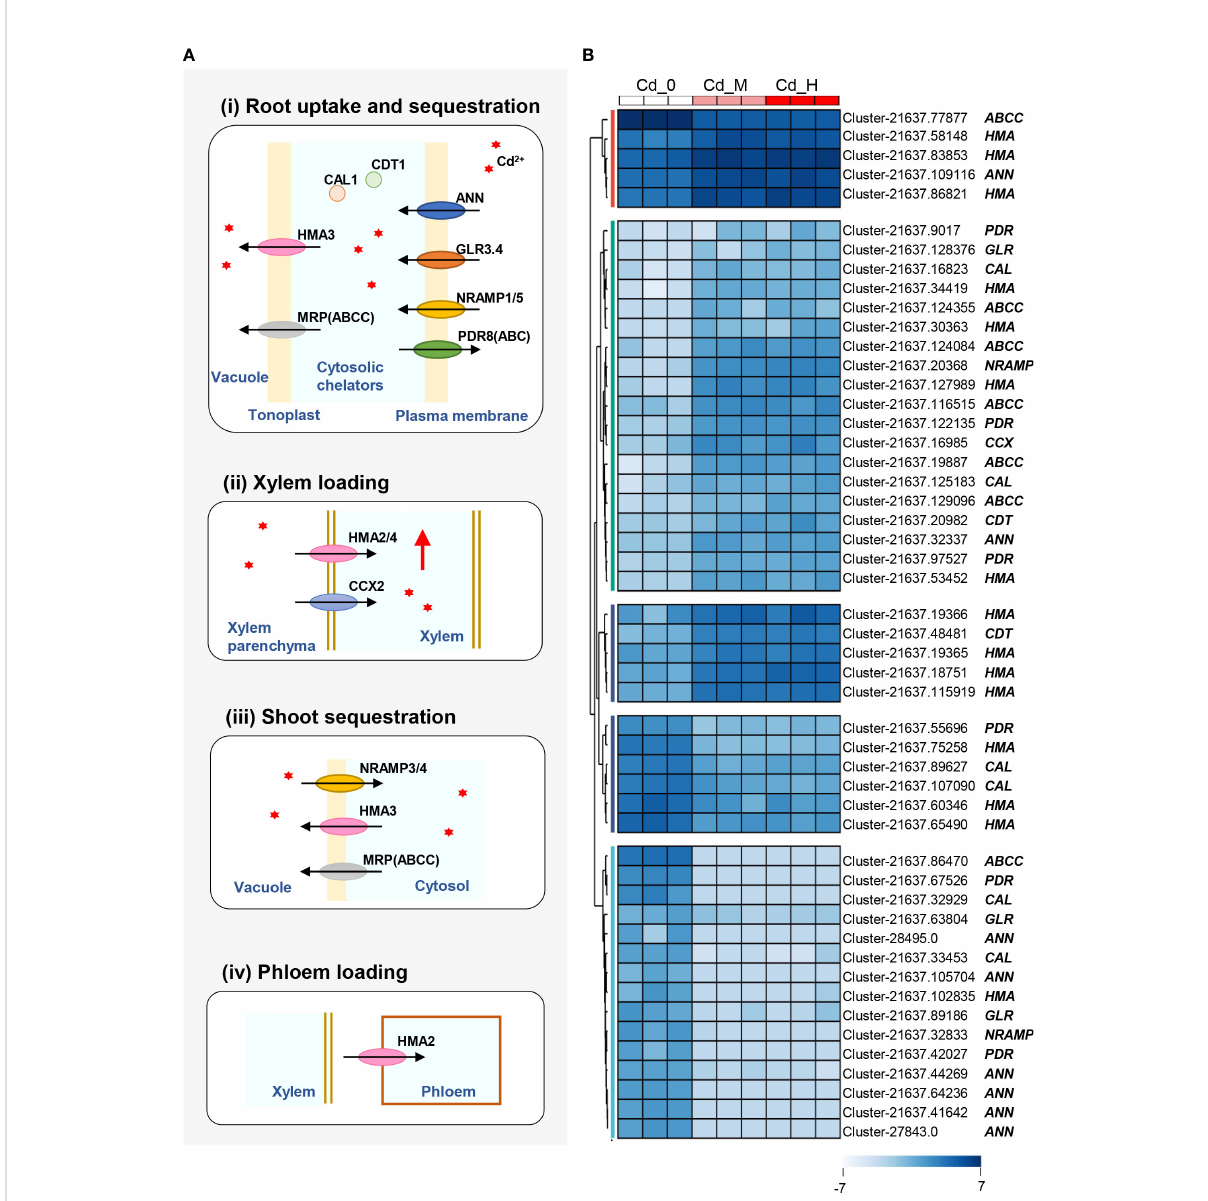
FIGURE 3 The DEGs of transporters/proteins involved in Cd accumulation. (A) The brief diagram of the transporters/proteins involved in Cd accumulation. (B) DEGs of transporters/proteins involved in Cd accumulation. The expression levels of DEGs were recorded as Log 2 (FPKM). Cd 2+ was symbolized by red